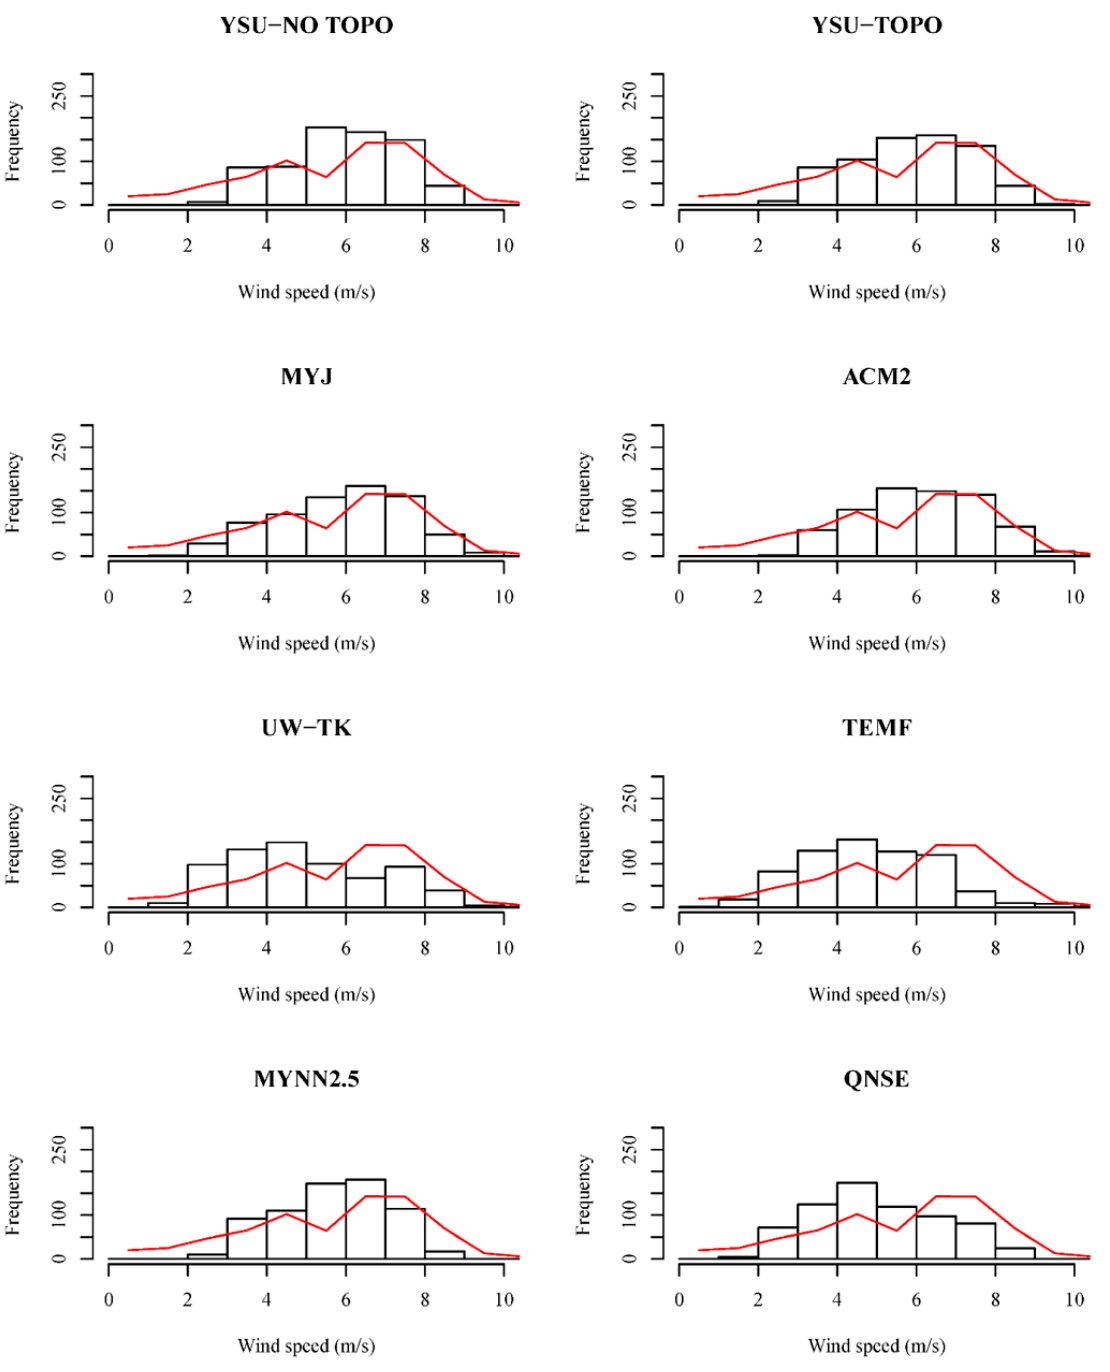
Figure 16. Histograms of simulated 10 m level wind speeds at Crown Point for April 2003. The red line denotes the observed wind speed histogram for April 2003.